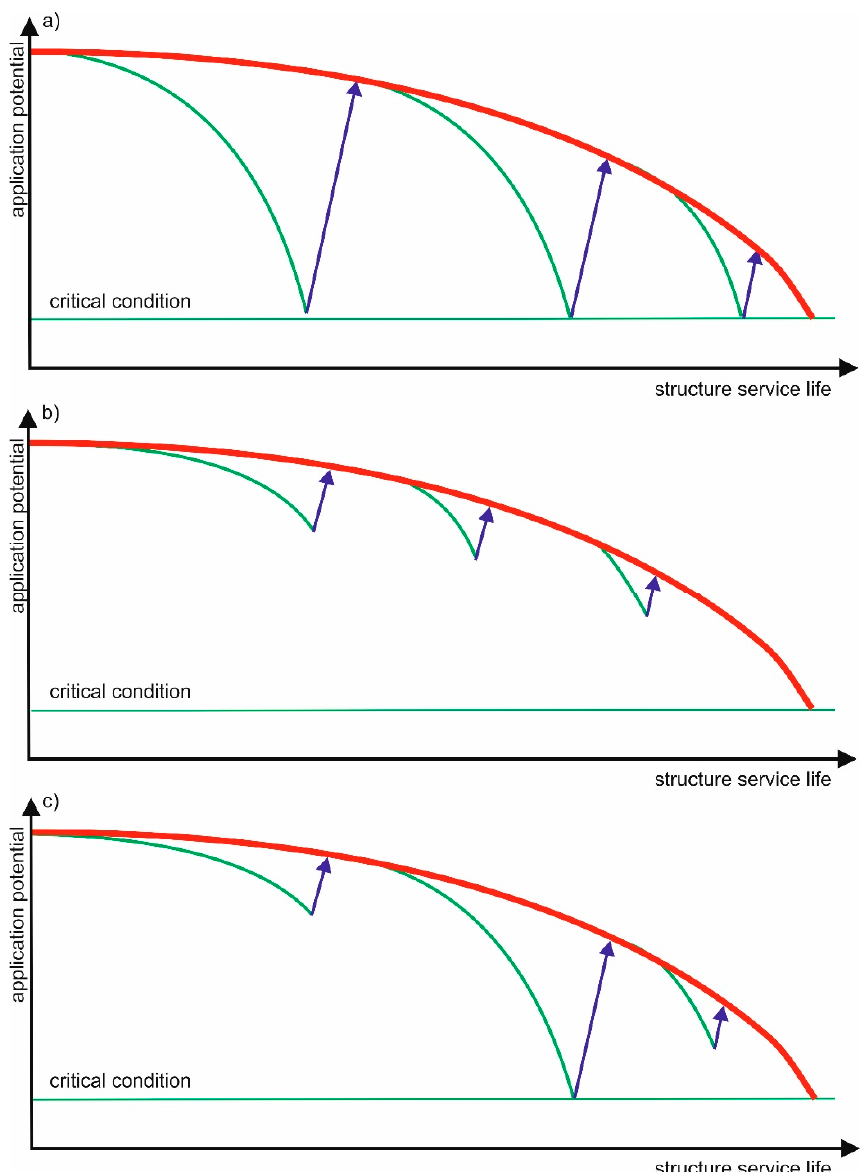
Figure 6. Schematic presentation of repair cycles carried out according to different durability management strategies [28,29]: ( a ) reactive model, ( b ) proactive model and ( c ) combined method red—designed wavelength of the use potential; green—actual wavelength of the use potential; blue—making the repairs.